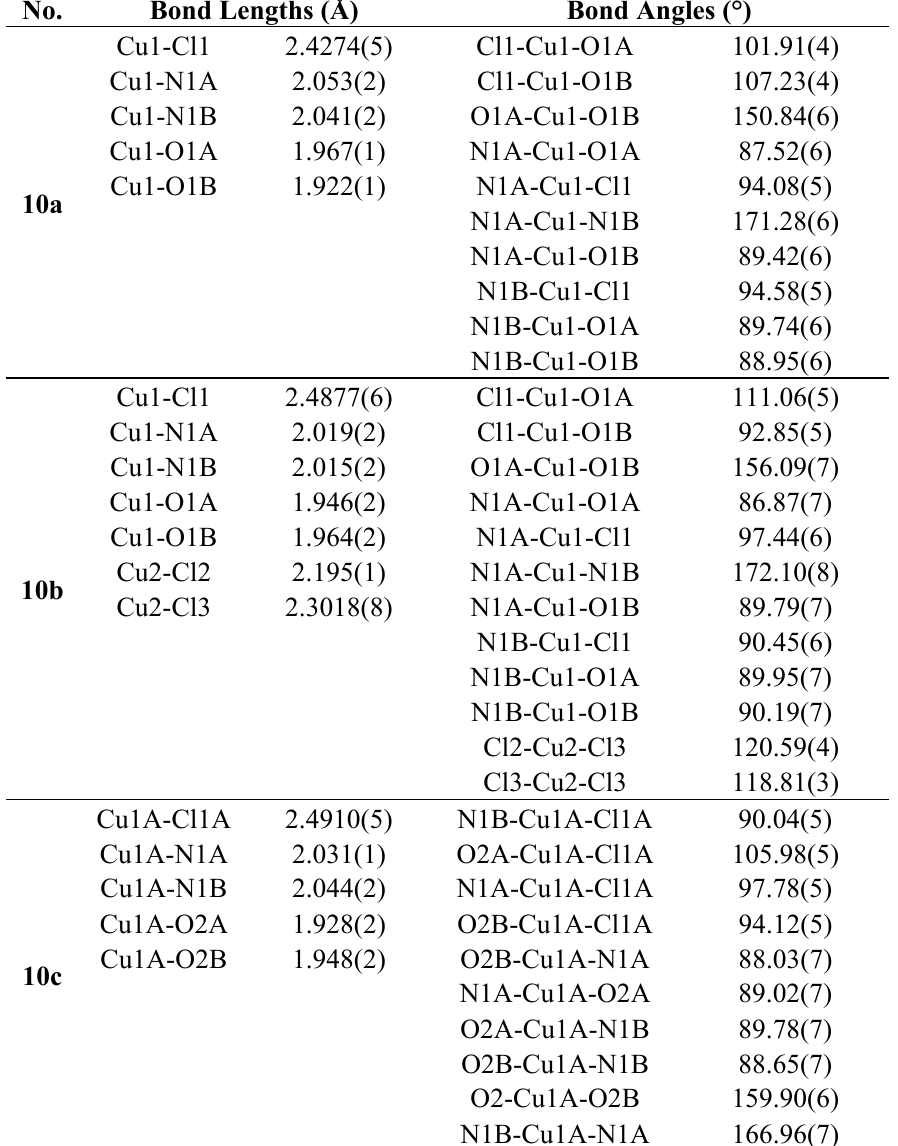
Table 7. Selected bond lengths and bond angles in copper(II) complexes 10a , 10b and 10c